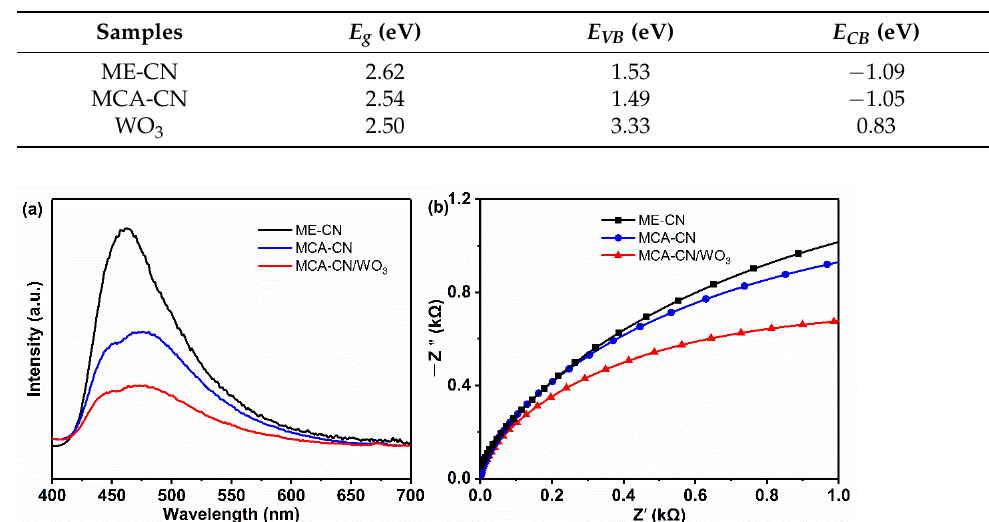
Figure 6. ( a ) DRS of MCA-CN/WO 3 , ME-CN/WO 3 and MCA-CN/WO 3 ; ( b ) corresponding plots of the transformed Kubelka − Munk function; ( c ) plots of the transformed Kubelka − Munk function. Table 2. Energy Band Potentials of ME-CN, MCA-CN and WO 3 .